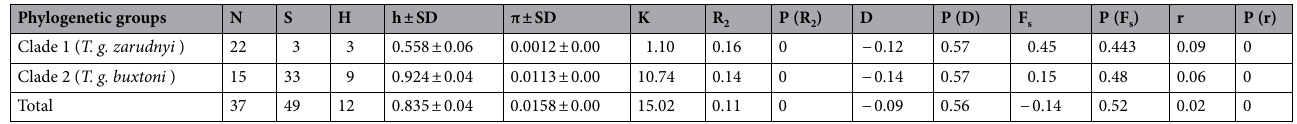
Table 1. Genetic diversity statistics for Testudo graeca in the contact zone between clade 1 ( T. g. zarudnyi ) and clade 2 ( T. g. boxtoni ). N, Number of individuals; S, Number of polymorphic sites; H, Number of haplotypes; h, Haplotype diversity; π, Nucleotide diversity; K, The average number of pairwise differences; R 2 , Ramos-Onsins and Rozas’s test; D, Tajima’s test; FS, Fu’s test; r, raggedness index. P (R 2 ), P (D), P (FS), and P (r) are p values of the statistical tests.